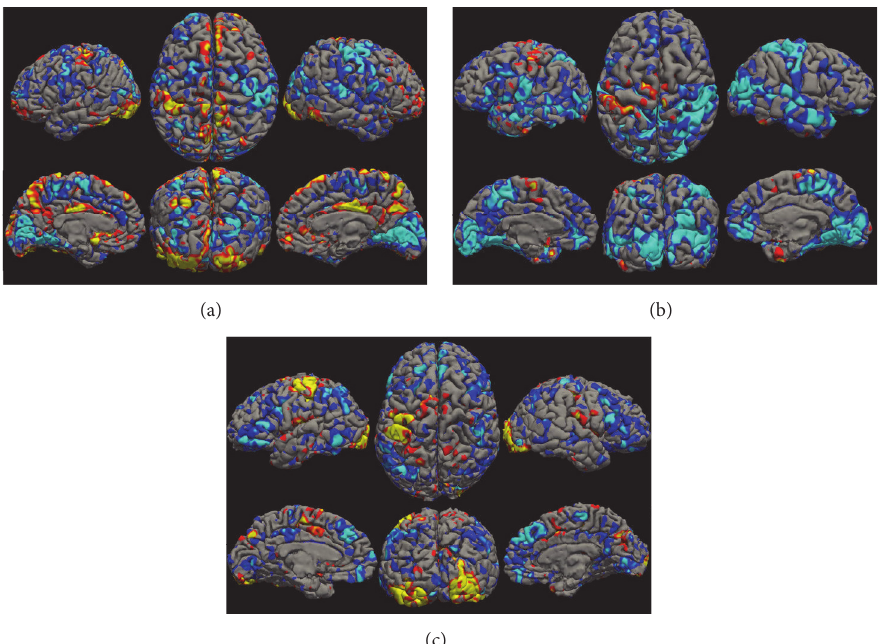
Figure 3: Unpleasant-face response versus baseline fMRI activation map showing regions of high BOLD signal for subjects #1, #2, and #3 in (a), (b), and (c),